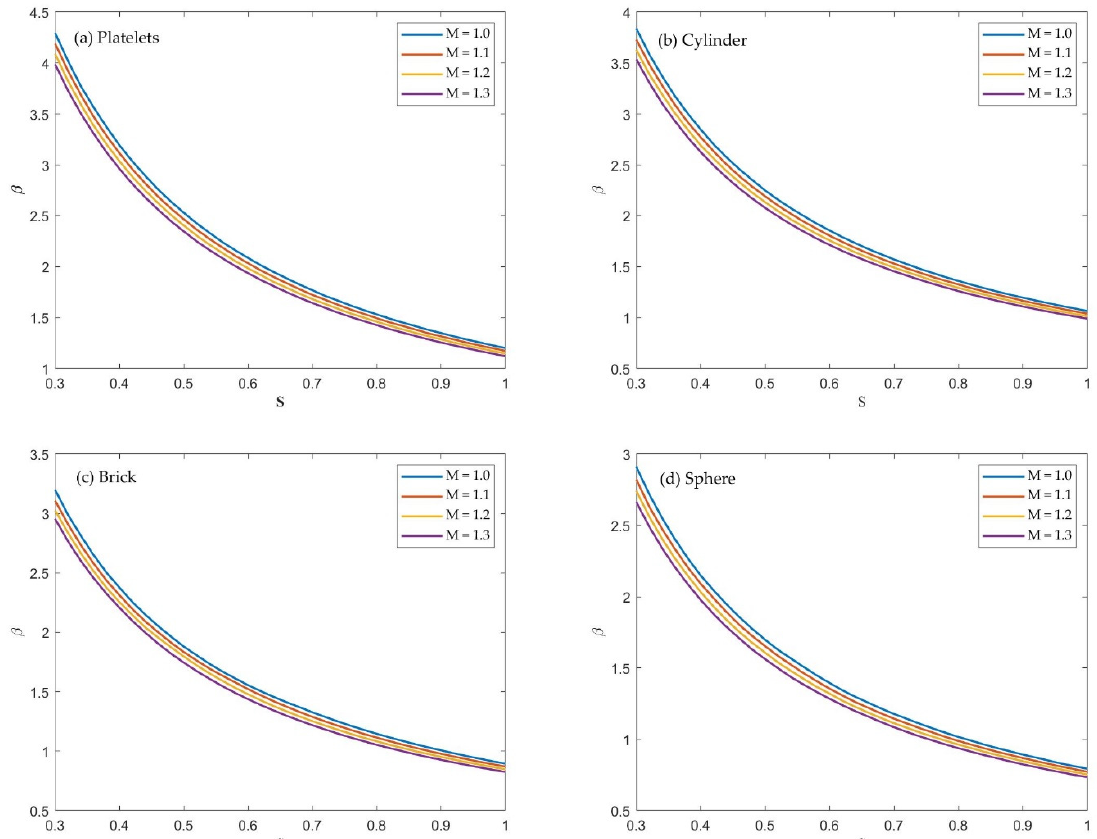
Figure 9. The film thickness 𝛽 against the unsteadiness parameter 𝑆 for diverse values of 𝑀 when 𝐾 = 0.5 and 𝜑 = 0.02 .